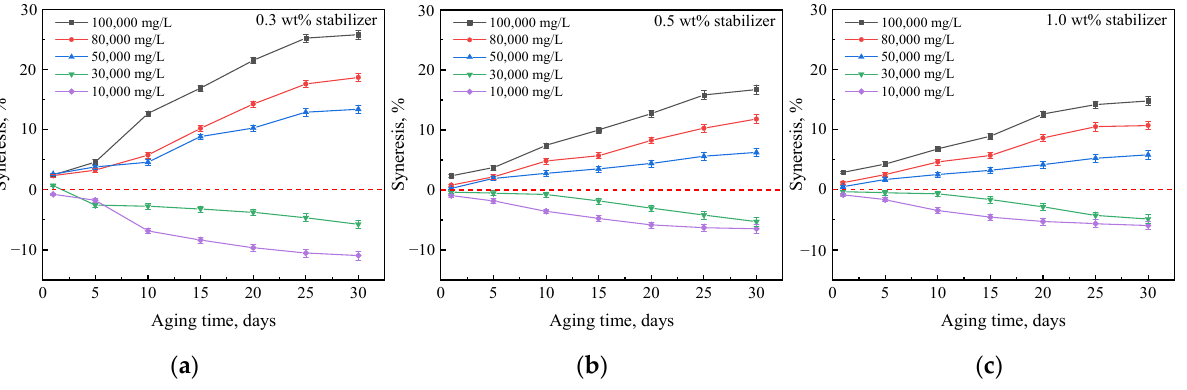
Figure 10. Mass changes of gels prepared with 0.5 wt% G3515, 0.5 wt% crosslinker, and different concentrations of stabilizer after aging in brines with different salinities: ( a ) 0.3 wt% stabilizer; ( b ) 0.5 wt% stabilizer; ( c ) 1.0 wt%